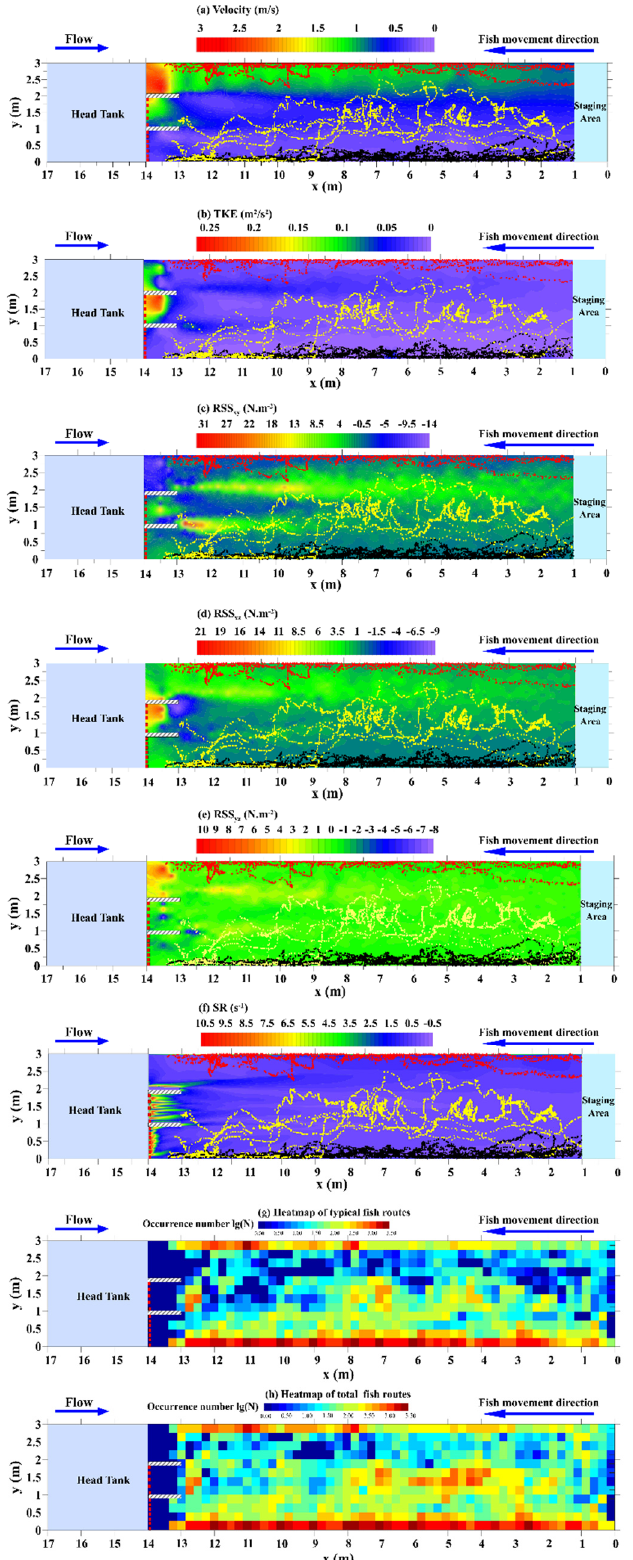
Figure 3. Typical fish swimming routes ( a–c ) against the contour plots of ( a ) flow velocity (m/s), ( b ) TKE (m 2 /s 2 ), ( c ) RSS xy (N . m − 2 ), ( d ) RSS xz (N . m − 2 ), ( e ) RSS yz (N . m − 2 ), and ( f ) SR (s − 1 ), as well as heatmaps of the fish occupancy number (lg(N)) in each cell: ( g ) typical fish swimming routes and ( h ) swimming routes of all fish.